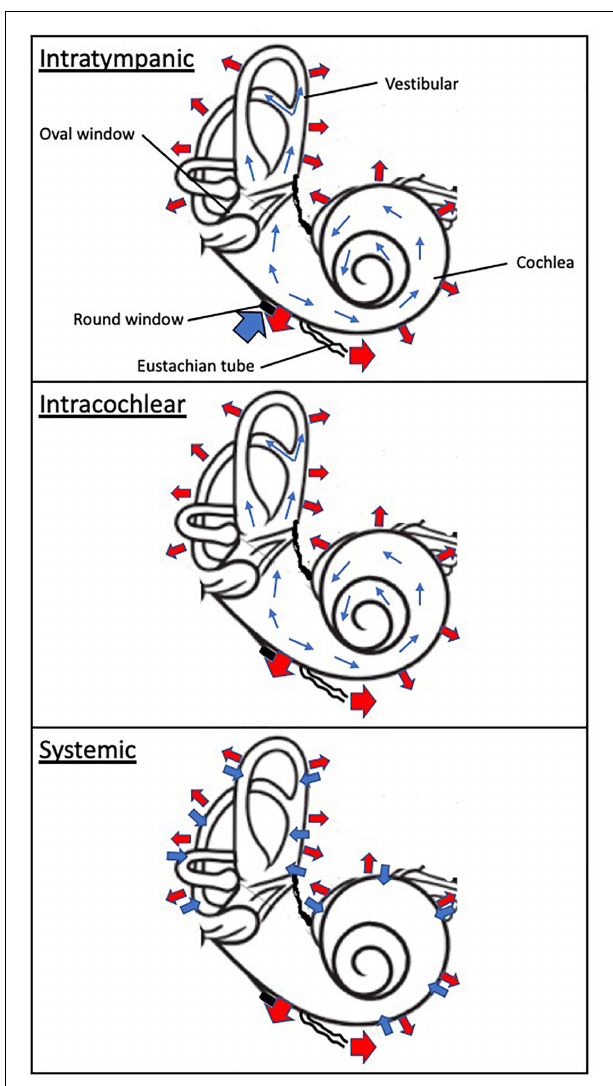
FIGURE 2 | Schematic of drug absorption and elimination following intratympanic, intracochlear, and systemic administration. The wide blue arrows indicate drug absorption to the inner ear compartment, including the cochlea and vestibular. The thin blue arrows denote distribution within the inner drug compartment. The wide red arrows depicts elimination from the otic compartment through (1) the inner ear blood circulatory system which interfaces throughout the cochlea and vestibular apparatus, (2) loss to the cochlear aqueduct and (3) loss to the middle ear. The black disk symbolizes the round